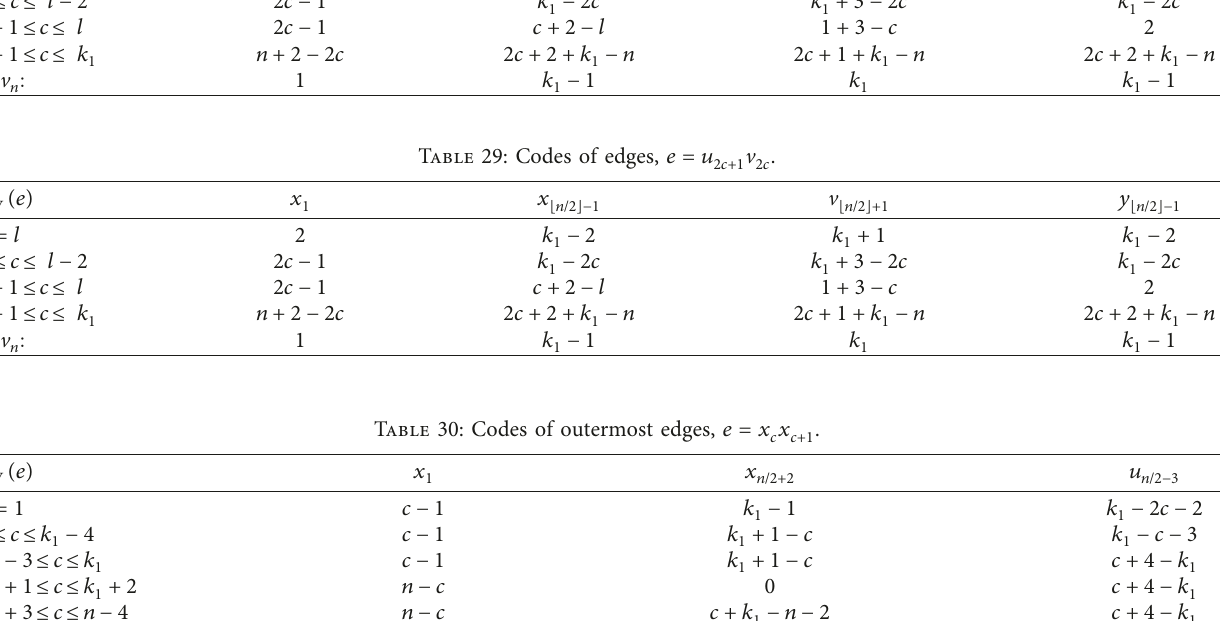
Table 28: Codes of edges, e � u